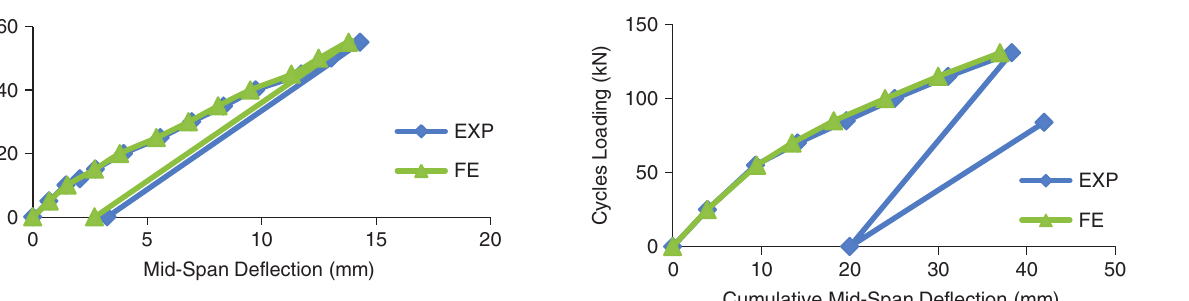
Fig. 16. Load against the de fl ection curve for pre-repair phase of the beam G3R2